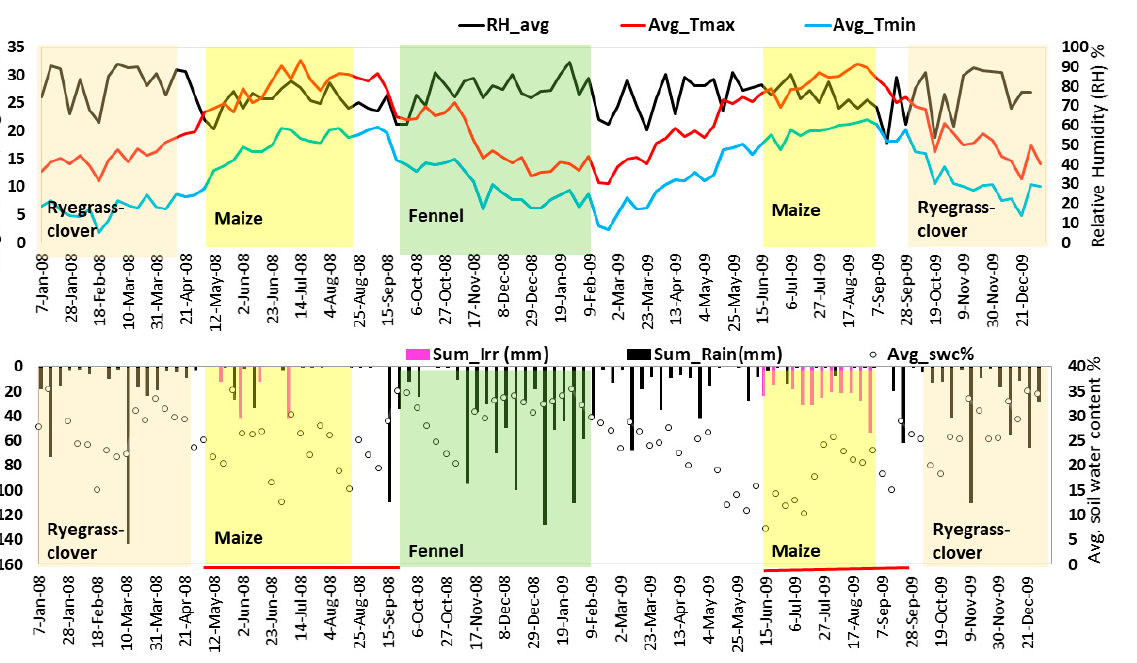
and week-days on the x -axis from 1 January 2008 to 31 December 2009. ( b ) Showing average soil water content % and a